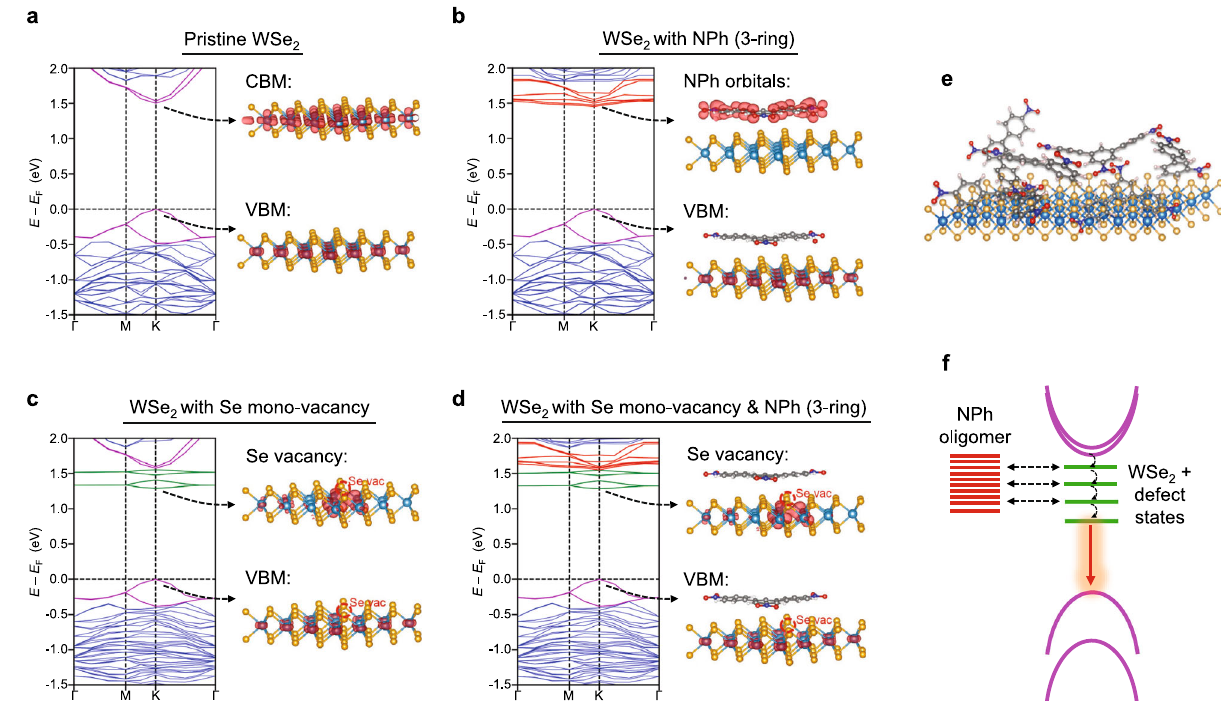
Fig. 5 | Density functional theory (DFT) calculations for 1L WSe 2 and nitro- phenyl(NPh)oligomers. Thebandstructurecalculationspresentedhereassumea 1%biaxialtensilestrainforthe1LWSe 2 substrate.TheFermienergy( E F )issettothe energyofvalencebandmaximum(VBM). a Pristine,defect-free1LWSe 2 .Here,blue: electronicbandsfromWSe 2 ,purple:spin – orbitsplitbandsofWSe 2 thatareclosest to the VBM and conduction band maximum (CBM) band edges. b 1L WSe 2 with a physisorbed NPh 3-ring oligomer. The real-space distribution of the density of states shows that the valence band maximum retains the WSe 2 character while the lowest energy of the weakly dispersive mid-gap states near the conduction band minimum (CBM) are localized at the NPh oligomer, suggesting the formation of a type-II heterojunction. Although the change in the WSe 2 conduction bands is minimal,thereisa fi nitecouplingofthebandstothehigherlyingNPhorbitals,and thustheconductionbandsnearCBMarealsocoloredinred. c 1LWse 2 withasingle